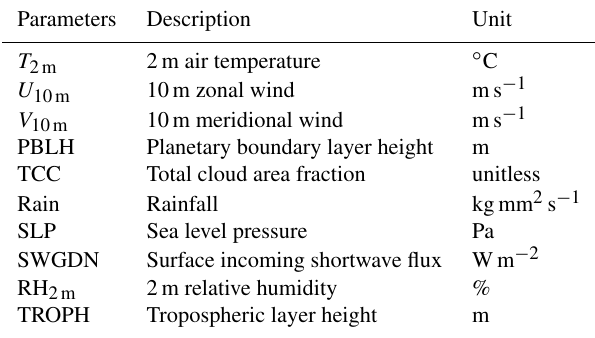
Table 2. Meteorological parameters used in the MLR